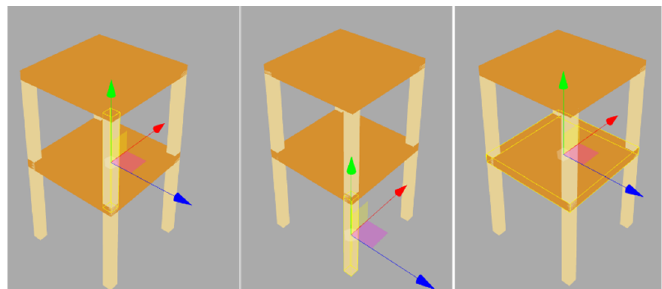
Figure 14. Local coordination at each element.